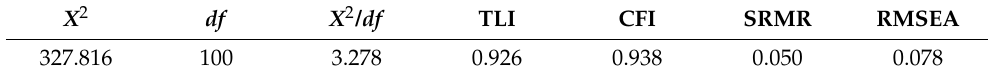
Table 3. Fit indexes for validated factor analysis of the Resilience Scale for Chinese